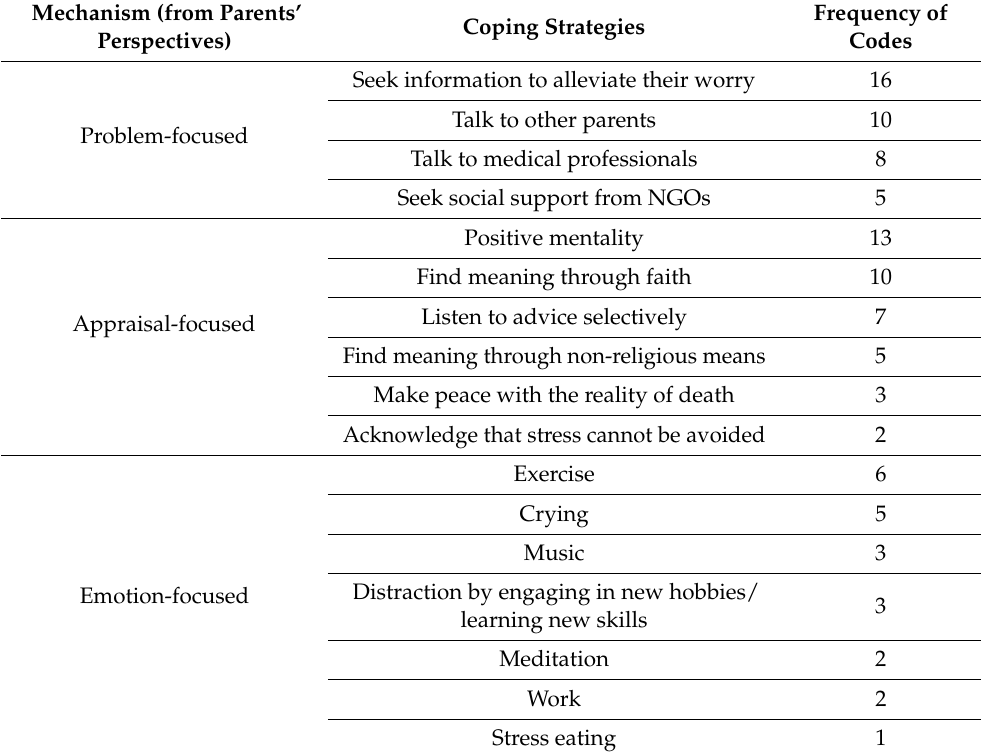
Table 4. Codes representing parents’ coping